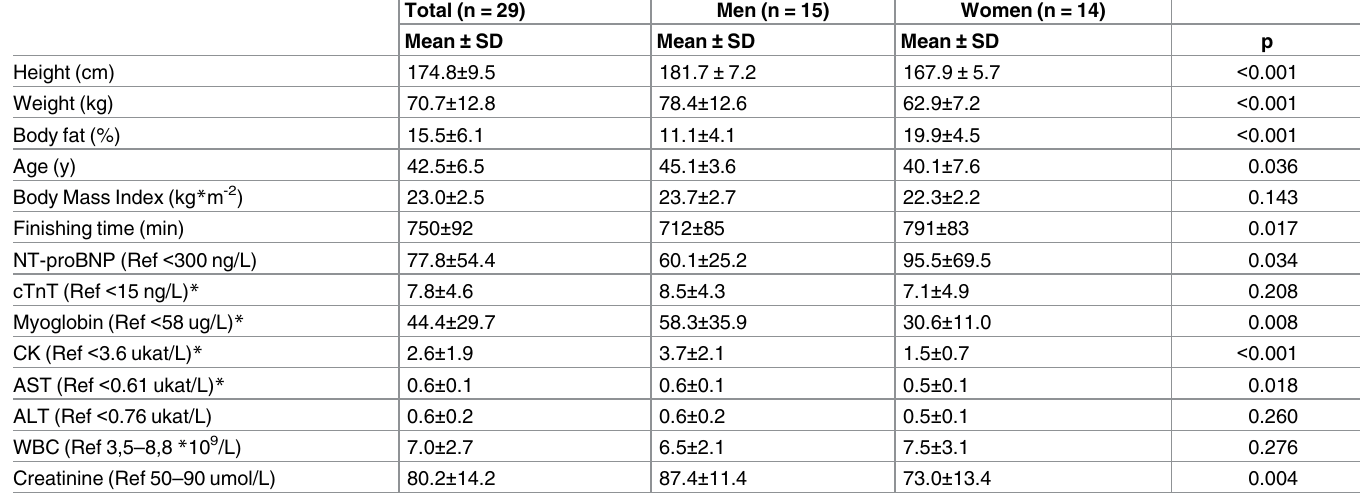
Table 1. Descriptivedata for the study sample and the biomarkers at baseline (T1). P-values are from independent samples t-test. Clinicalreference (Ref) values are provided.